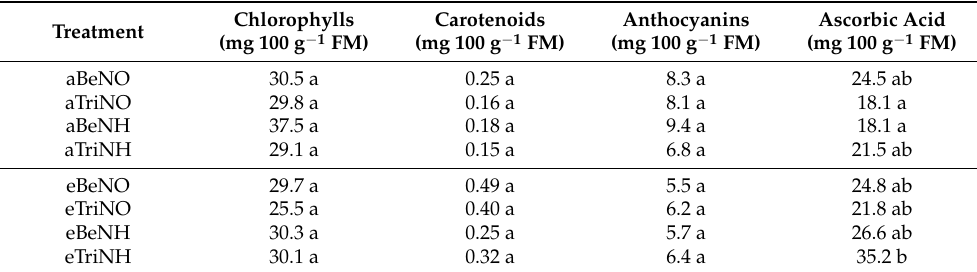
Table 3. Pigment and ascorbic acid contents of leaves of two arugula varieties grown with two different N forms and two atmospheric CO 2 concentrations. n = 3.